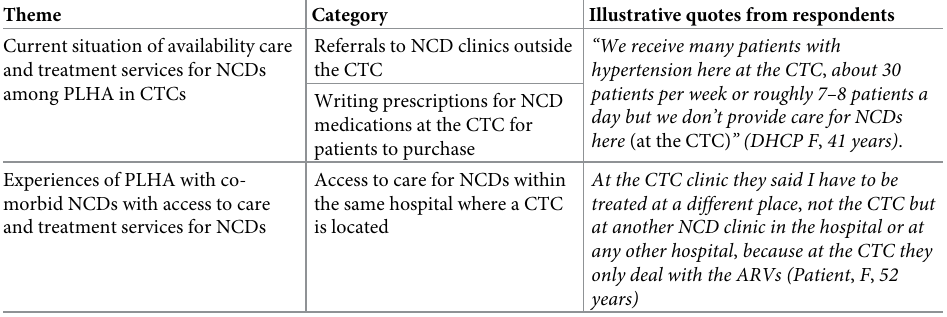
Table 1. Example of the analysis process of the main theme, categories and illustrative quotes from respondents. Theme Category Illustrative quotes from respondents Current situation of availability care and treatment services for NCDs among PLHA in CTCs Experiences of PLHA with co- morbid NCDs with access to care and treatment services for NCDs